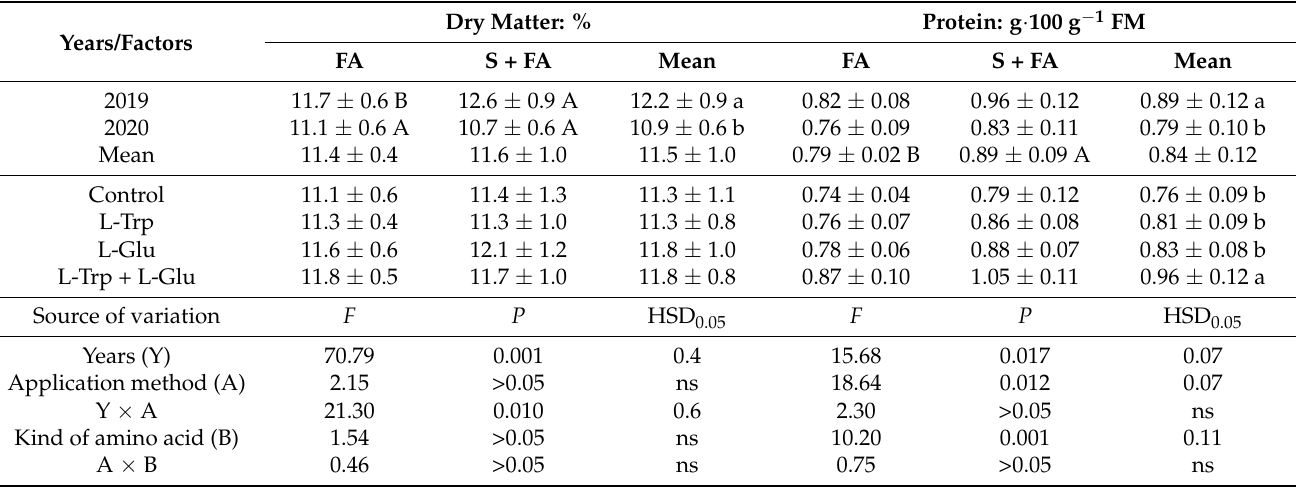
Table 6. The effect of L-tryptophan and L-glutamic acid, methods of their application, and years on dry matter and protein content in carrot storage roots.